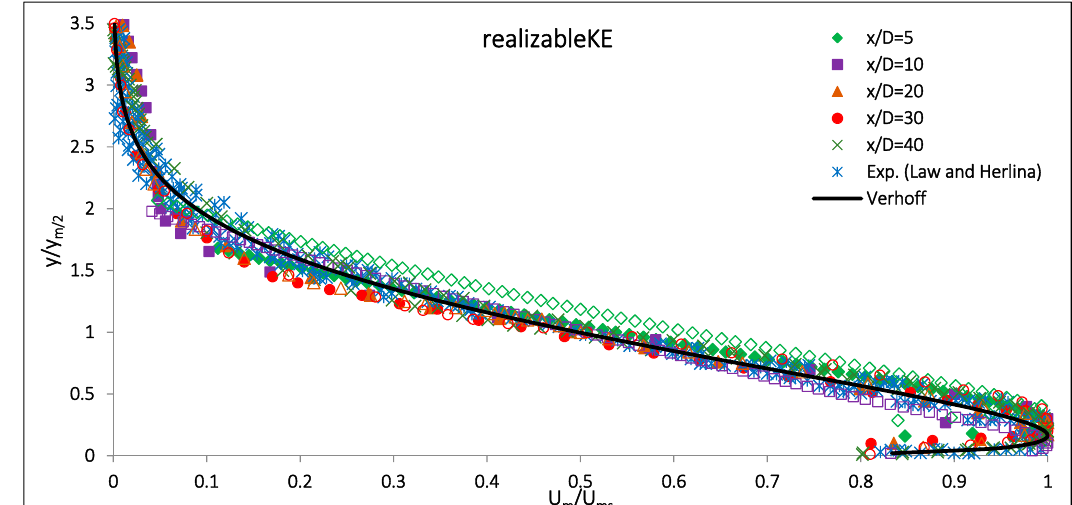
Figure 10. Velocity at offset sections z/D = 1.818 and 3.636. Solid fill scatters are for z/D = 1.818 and the no-fill scatters are for z/D = 3.636 at the x/D values on the plot.